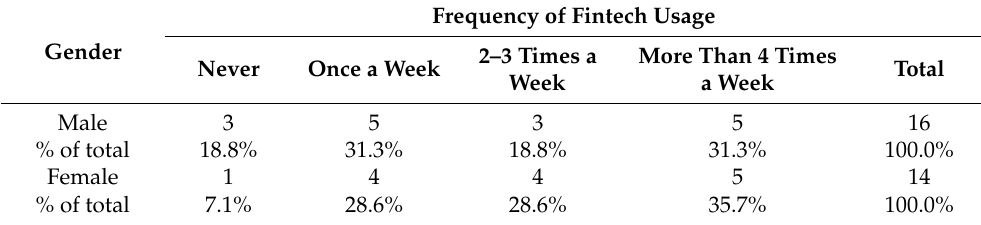
Table 9. Respondents’ gender and Fintech usage frequency.